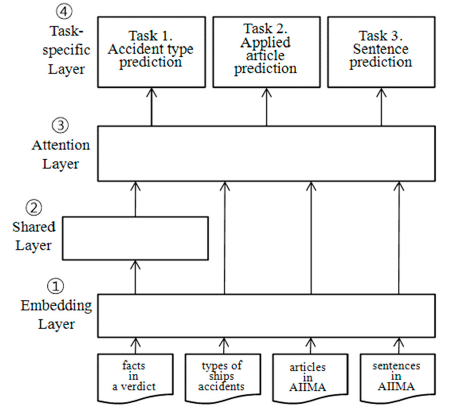
Figure 4. Overall structure of the proposed model.